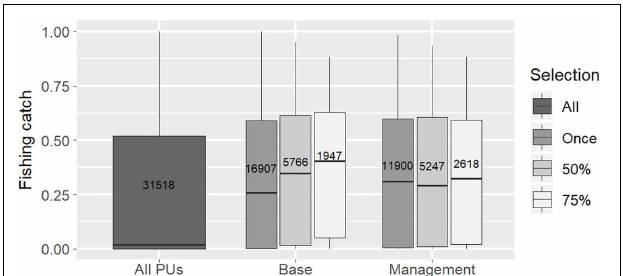
FIGURE 7 | Distribution of costs associated with the fishing catch index (log of fishing catch +1, rescaled between 0 and 1) and total number of PUs selected (in box) for all PUs and for “Base” and “Management” scenario solutions (according to frequency of PU selection in solutions: selected at least once, ≥ 50% or ≥